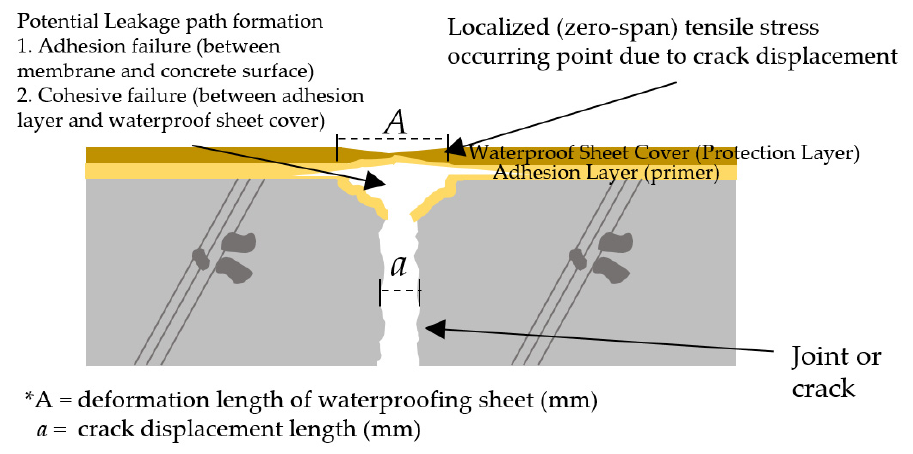
Figure 3. Zero-span tensile stress on waterproofing membrane due to joint or crack opening.